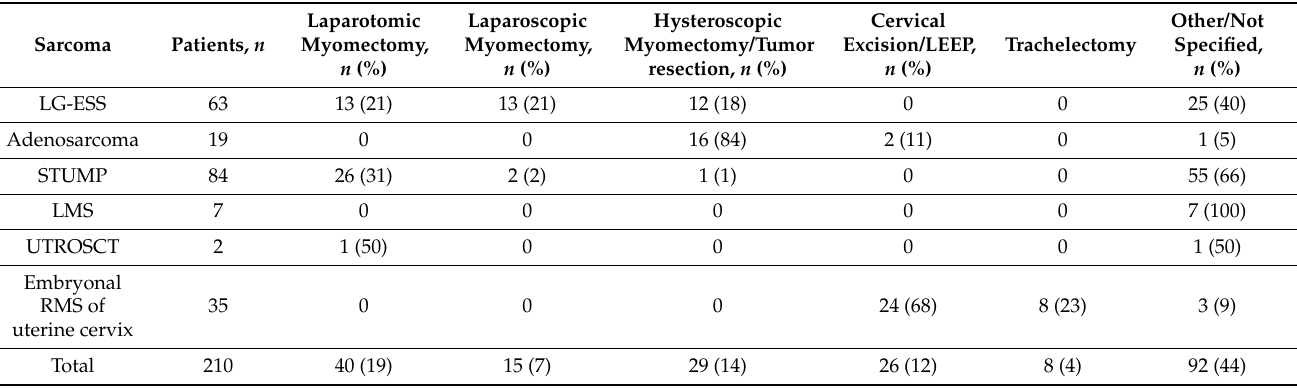
Table 9. Surgical approach for FST of uterine